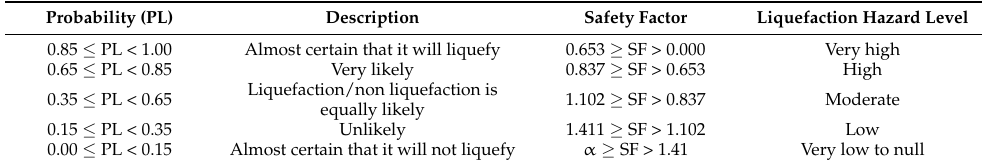
Table 4. The classification of the probability of liquefaction as proposed by Chen and Juang